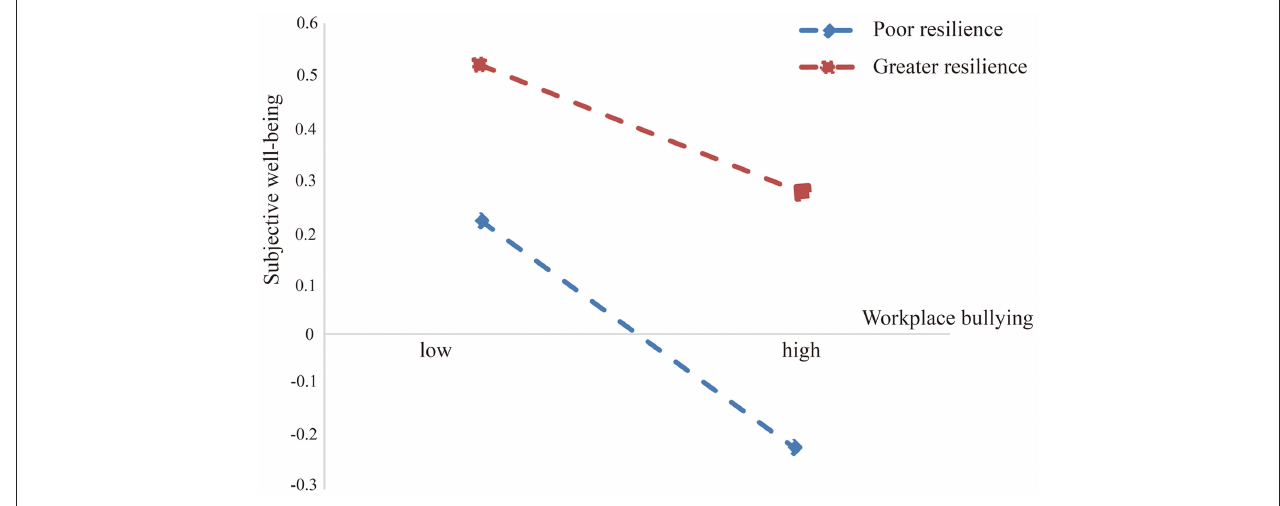
FIGURE 2 | Simple slope analysis of the moderating effect of